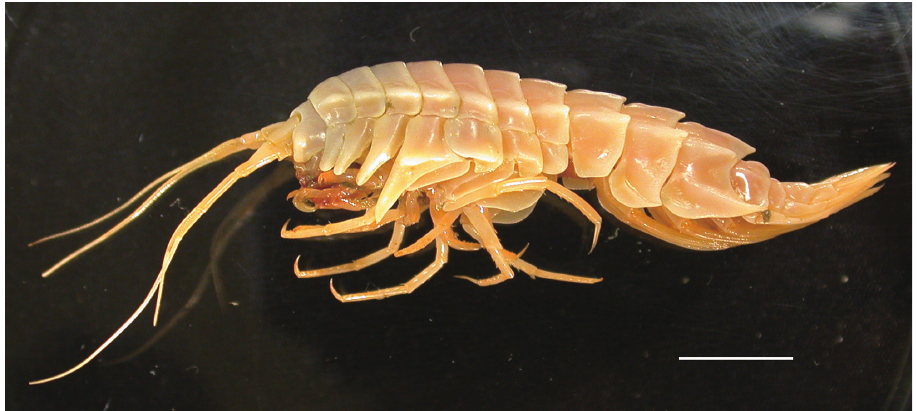
Figure 11. Epimeria abyssalis sp. n., paratype female (KMNH IvR 500906) photographed on board shortly after sampling. Scale bar: 10